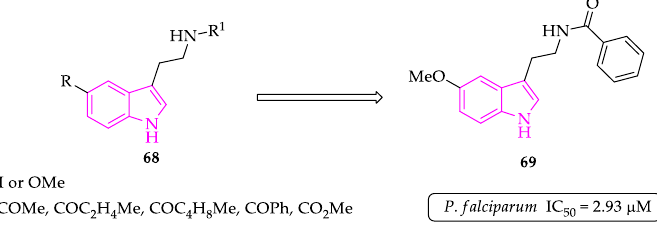
Figure 6. Melatonin derivatives tested against P. falciparum .